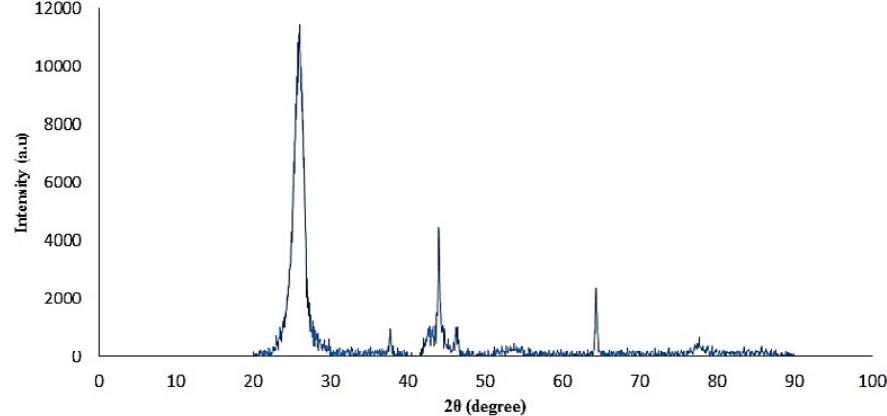
Fig. 2. XRD pattern for MWCNT nanoparticle.